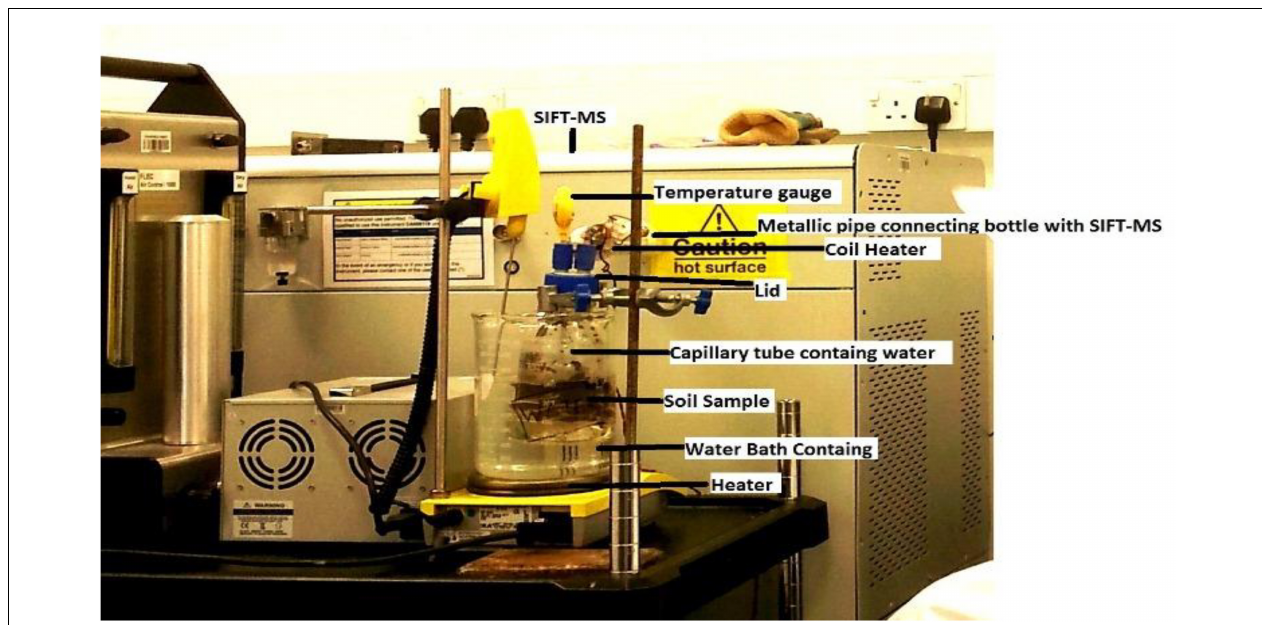
FIGURE 2 | Photograph of the selected-ion flow-tube mass spectrometer (SIFT-MS) showing the analysis procedure for the measurement of gaseous emissions from soil samples taken from the arable